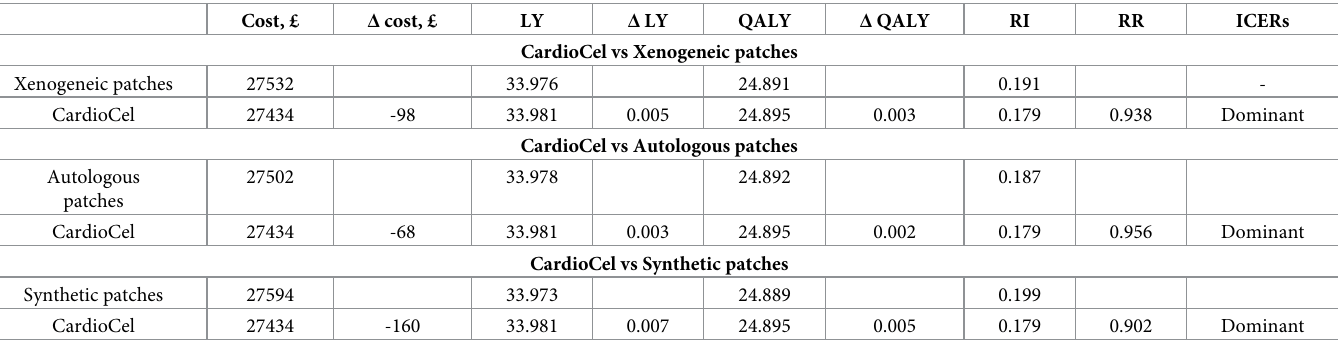
Table 10. Base-case cost-effectiveness